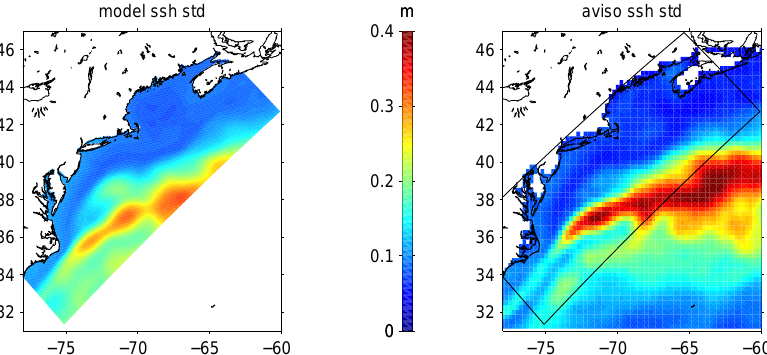
Figure 4. Comparison of altimeter-observed and model-simulated sea surface height standard deviation for the period from January 2004 to December 2013. Spatial correlation between the results of model and AVISO is 0.89.